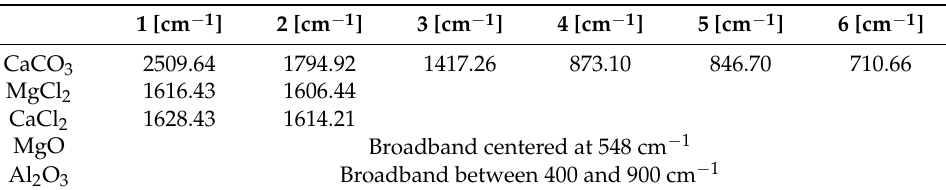
Table 10. Main FTIR bands in the